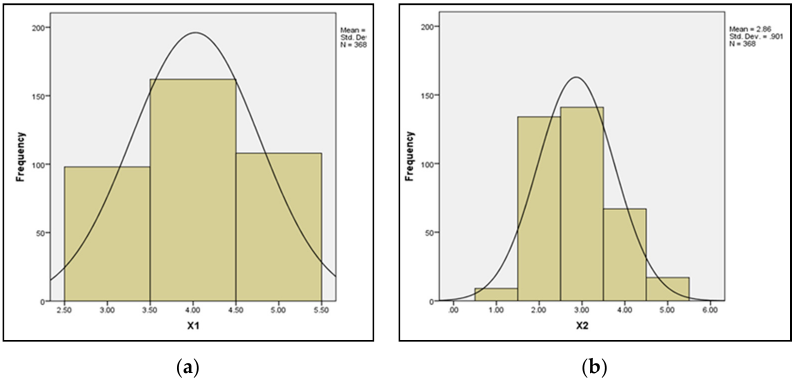
Figure 10. Normality graphs of variables. ( a ) Buildings with pleasing appearance; ( b ) Buildings to children’s scale.